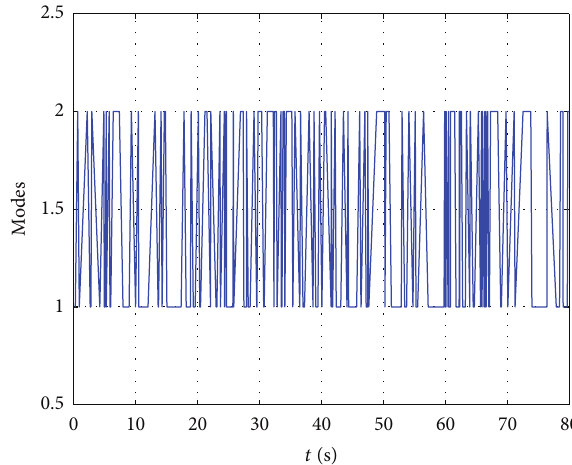
Figure 1: Operation modes of Example 1.